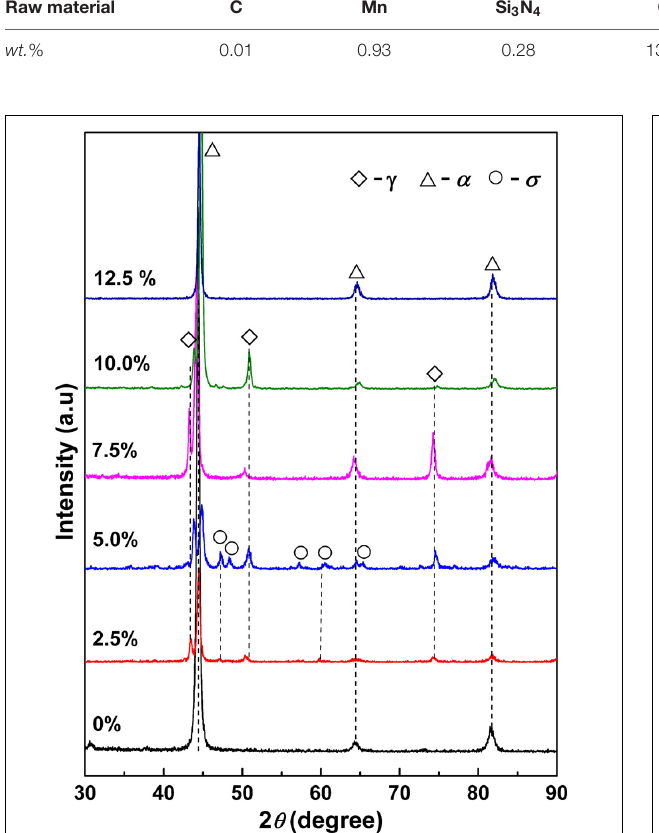
FIGURE 2 | Metallographic images of 2205 DSSs prepared with different Fe 2 O 3 excess percentages: (A) 0%, (B) 2.5%, (C) 5.0%, (D) 7.5%, (E) 10.0%, and (F)